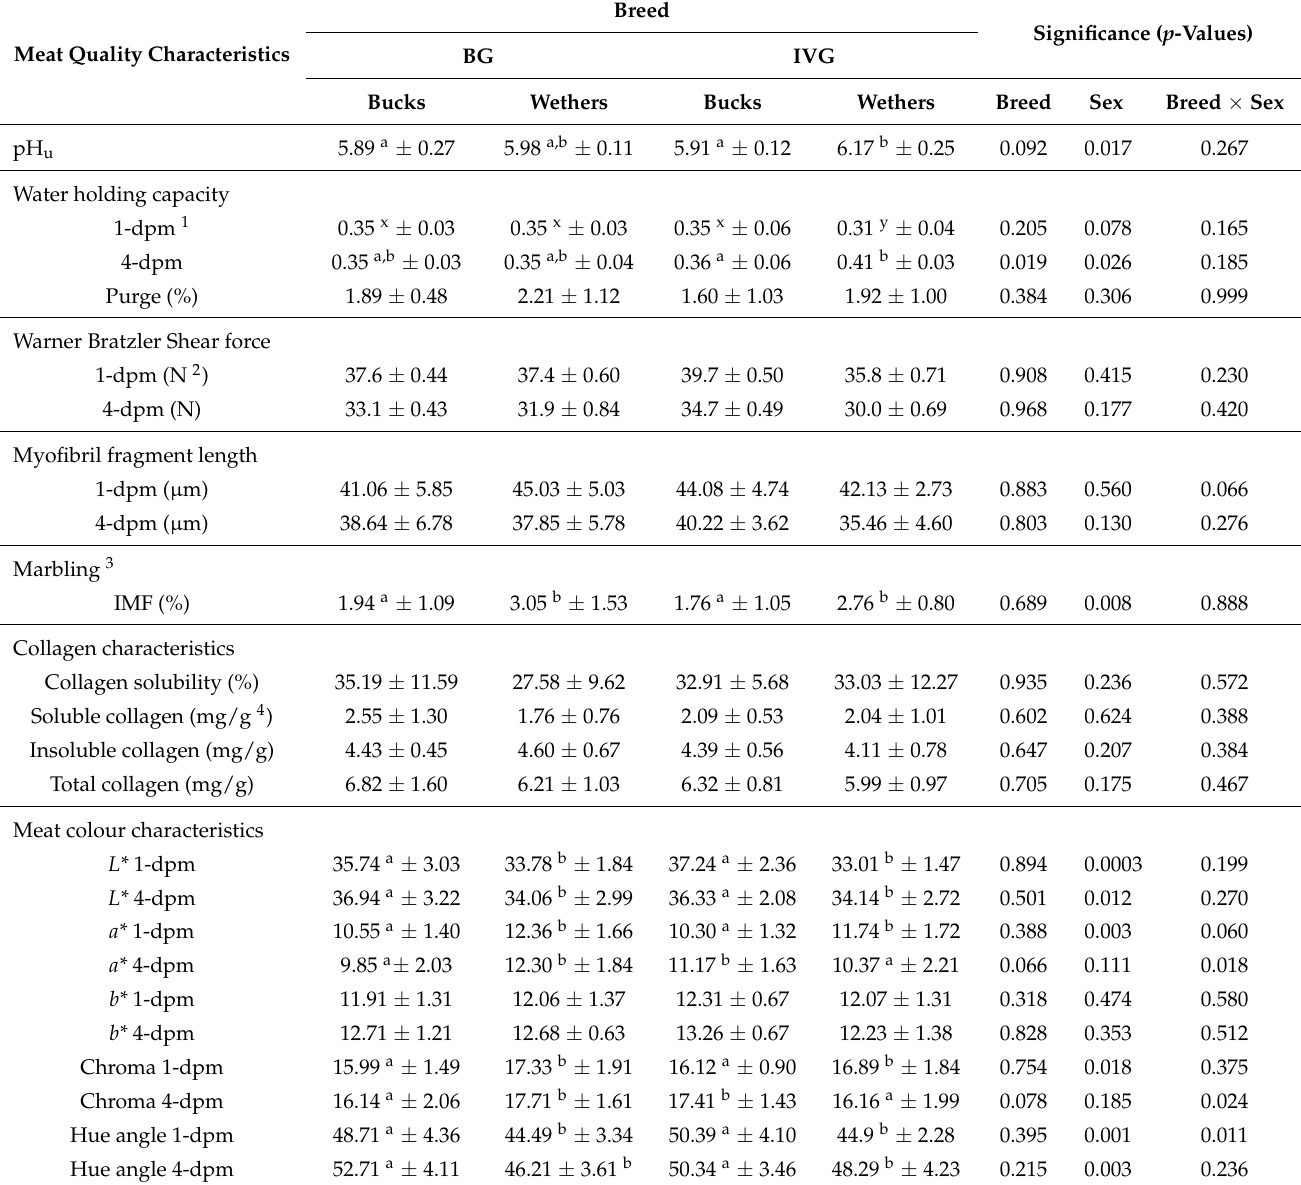
Table 3. Least square means and standard error of means for meat tenderness, meat colour and related physiological characteristics of buck and wether Boer Goat (BG) and Indigenous Veld Goats (IVG) of Semimembranosus (SM)